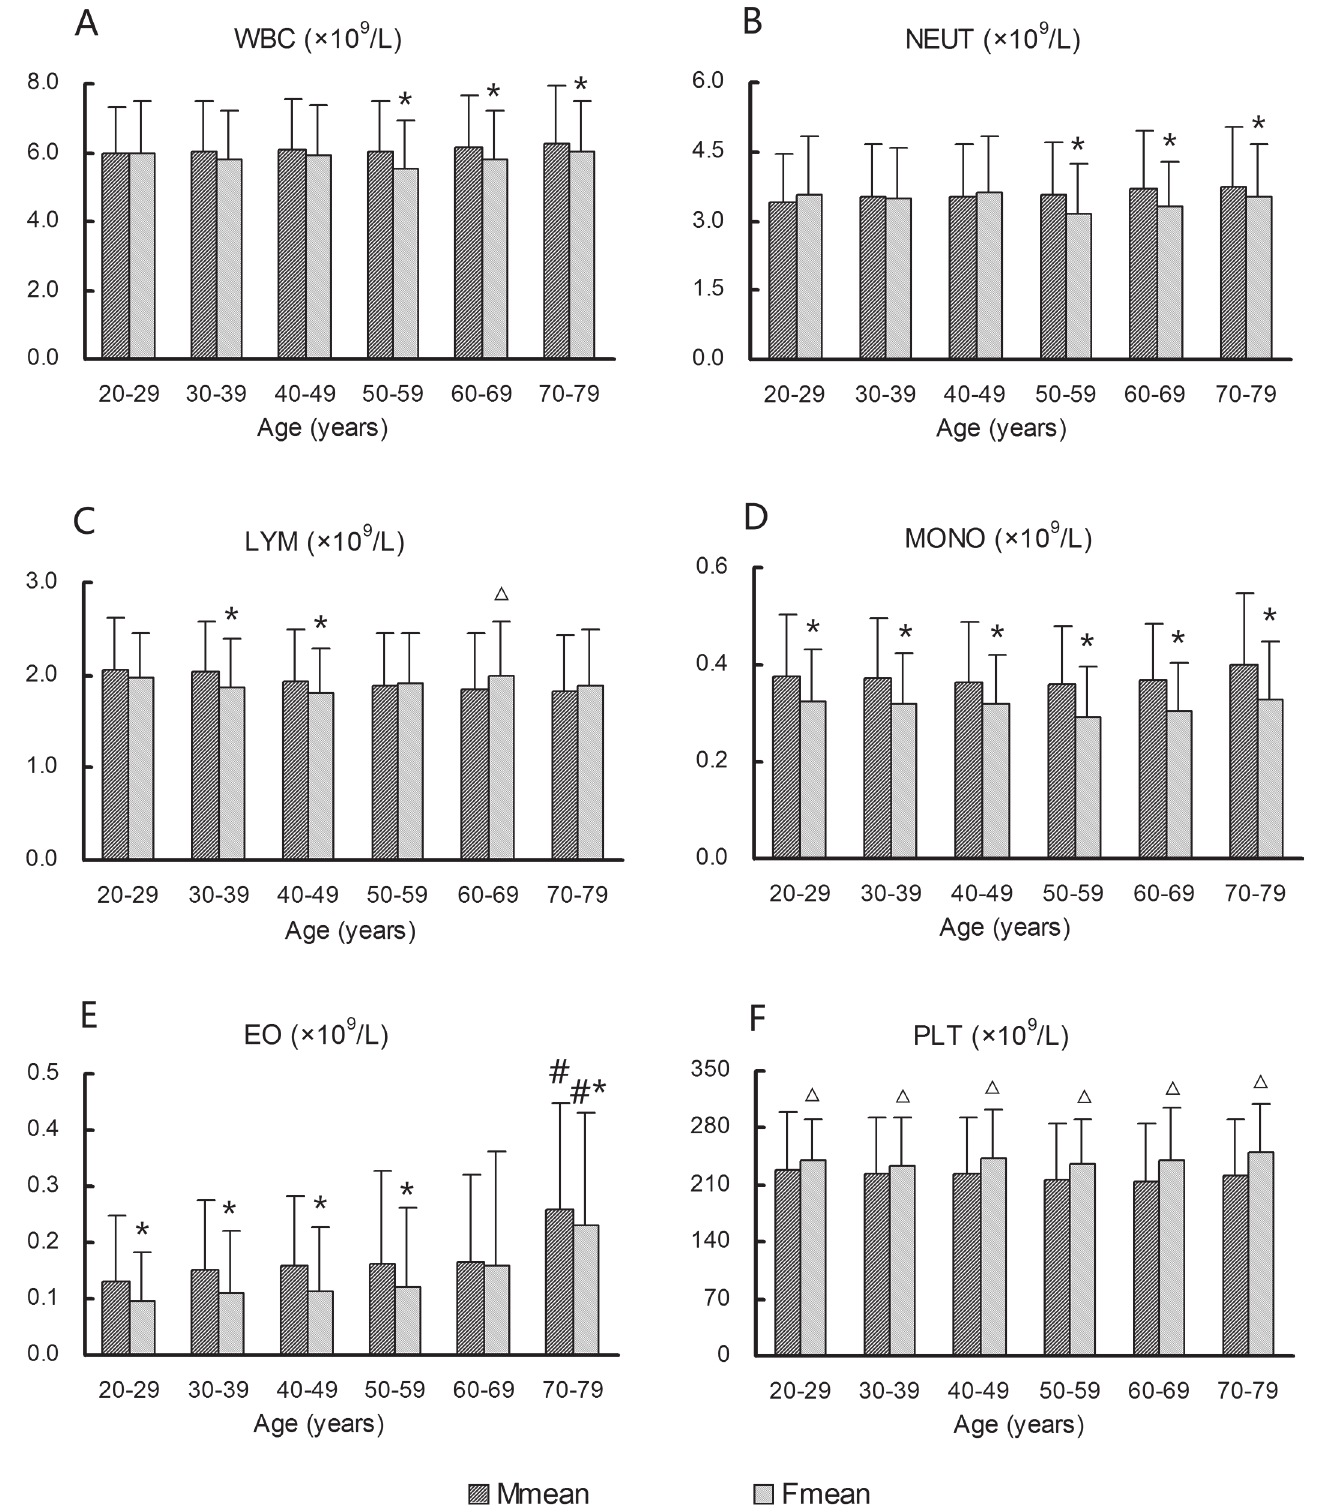
Fig 4. Variations in white blood cell (WBC) profile and platelet count (PLT) according to age and sex. (A) WBC, (B) neutrophils (NEUT), (C) lymphocytes (LYM), (D) monocytes (MONO), (E) eosinophils (EO), (F) PLT. * Females show significantly lower values ( P < 0.05) than males in the same age group. 4 Females show significantly higher values ( P < 0.05) than males in the same age group. #EO values are significantly higher ( P < 0.05) in the 70 – 79- year age group than in other age groups in males and females,